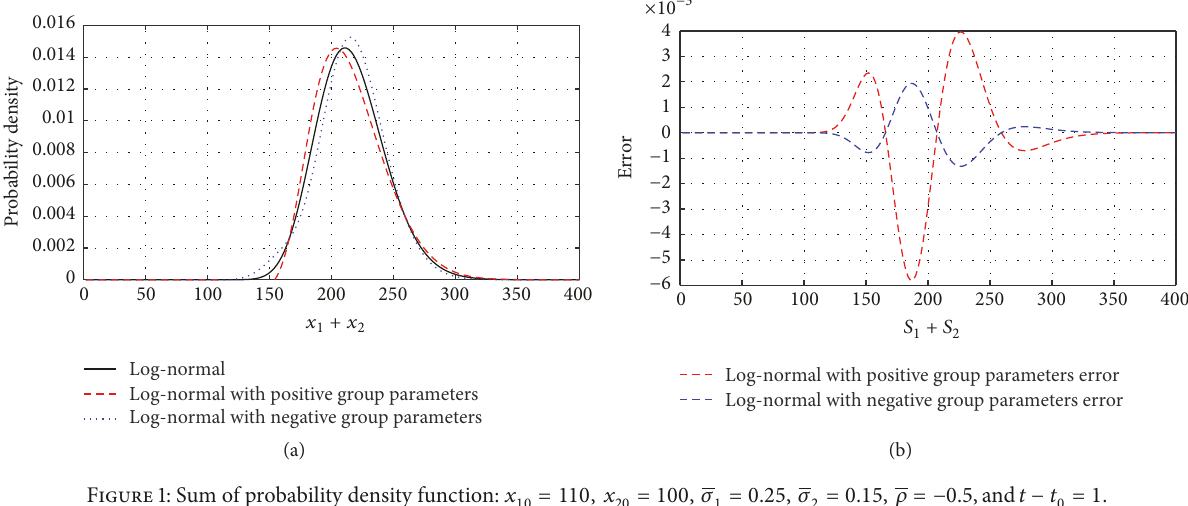
Figure 1: Sum of probability density function: 𝑥 10 = 110 , 𝑥 20 = 100 , 𝜎 1 = 0.25 , 𝜎 2 = 0.15 , 𝜌 = −0.5 , and 𝑡 − 𝑡 0 = 1